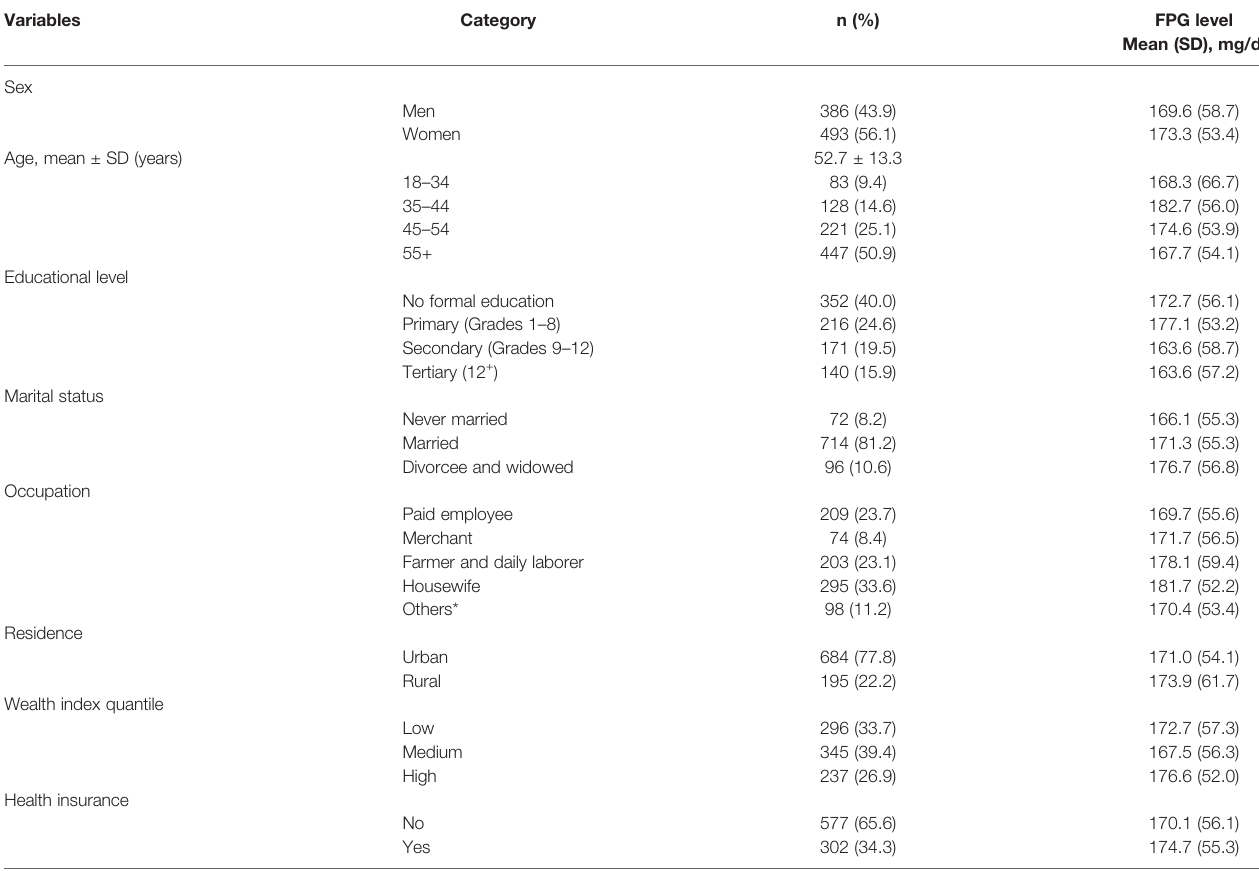
TABLE 1 | Demographic characteristics by glycemic levels of patients with T2D in Eastern Ethiopia, 2020/2021 (n = 879).